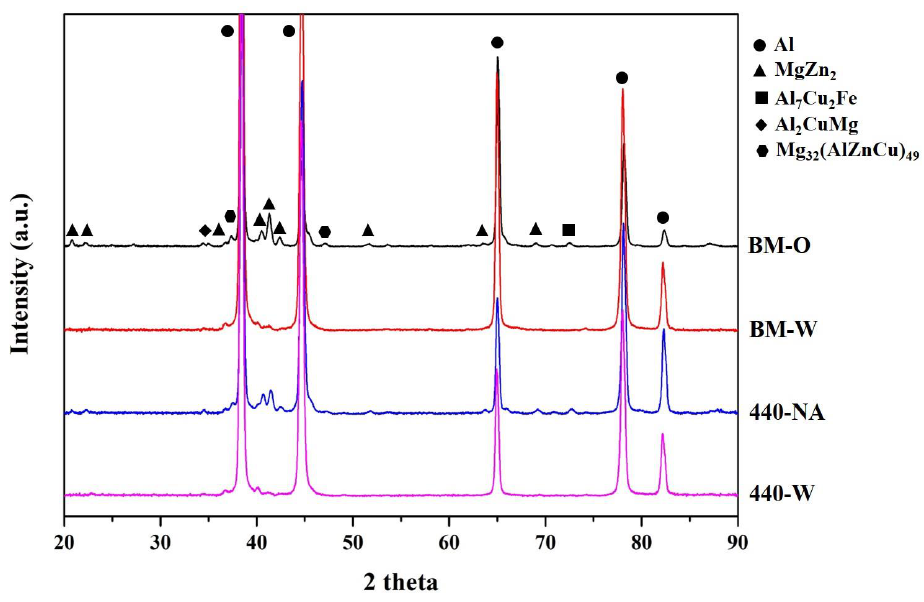
Figure 7. The XRD analysis of 7075 aluminum alloy after FSP and various heat treatments.